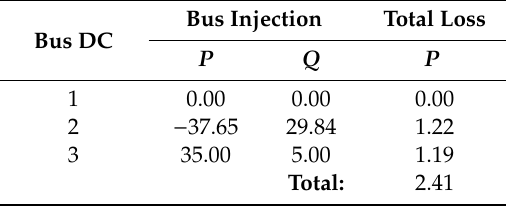
Table A10. Results of the mixed AC / DC PF calculations in Case 3. DC bus data.